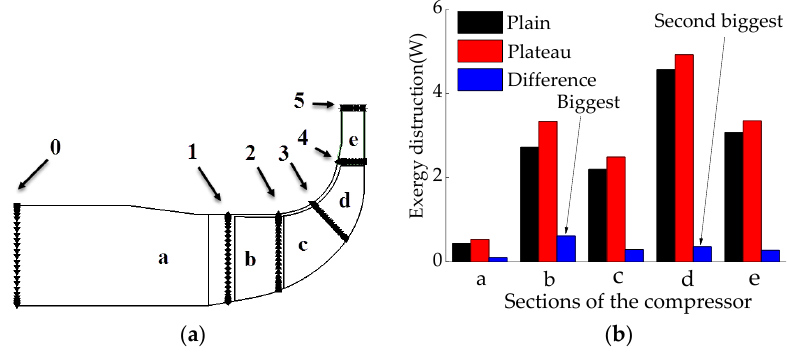
Figure 15. Exergy destruction comparison analysis: ( a ) Sections of the compressor passage; ( b ) Exergy destruction in the compressor.